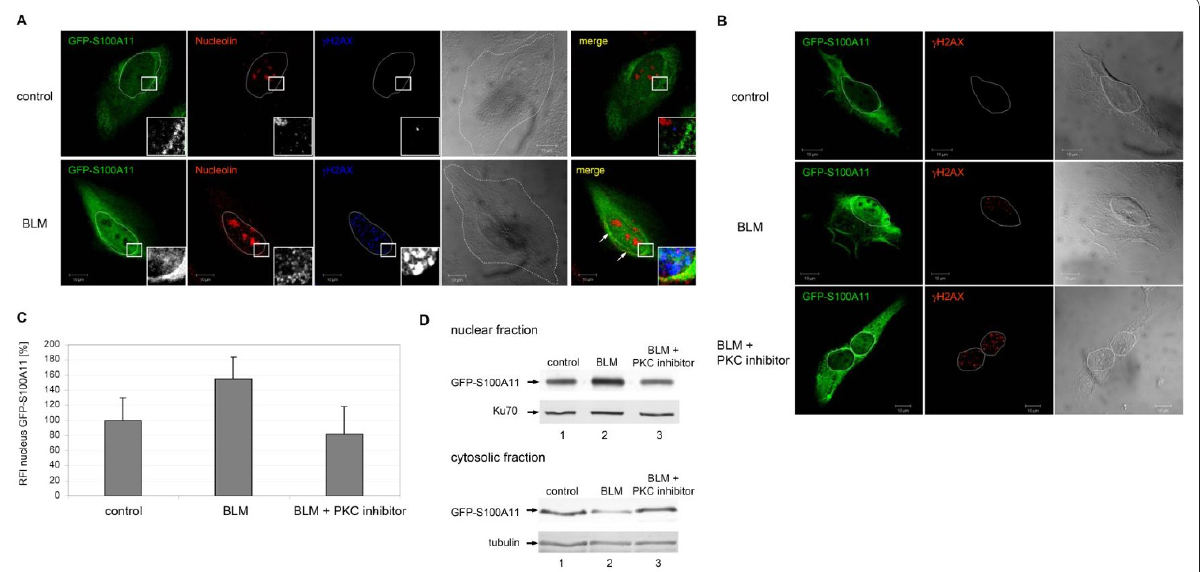
Figure 3 Nucleolin distribution during nuclear translocation of S100A11 in DNA damaged cells . (A) U-2 OS cells which expressed GFP- S100A11 were treated with BLM to induce DSB for 1 h followed by immuno-staining against GFP-S100A11 (green), nucleolin (red) and g H2AX (blue). The overlay image (merge) shows that GFP-S100A11 and nucleolin partially colocalize in the perinuclear region (labeled by arrows) in cells containing damaged DNA compared to control cells. Areas marked by a rectangle are shown enlarged in each image as insets. (B) Inhibition of phosphorylation of S100A11 by a myristolated PKC inhibitor interferes with S100A11 translocation. U-2 OS cells were transfected with a GFP- S100A11 construct and treated with BLM for 30 min or pre-treated with a PKC inhibitor for 17 hrs and subsequently with BLM. Cells were analyzed by two-color immunostaining followed by laser scanning microscopy for GFP-S100A11 (green) and g H2AX (red). (C) Quantification of the GFP-S100A11 relative fluorescence intensity (RFI) in nuclei of cells treated with BLM or BLM and a PKC inhibitor and in control cells by assessment of the GFP-S100A11 fluorescence intensity in several nuclear areas (2 μ m diameter) in percent. At least 14 cells for each condition were analyzed for quantification. Data are displayed as mean values (±SD). The average of the GFP-S100A11 fluorescence intensity measured in the control approach was set as 100%. (D) U-2 OS cells which expressed GFP-S100A11 were treated with BLM or with both BLM and the myristoylated PKC inhibitor. Afterwards, cytoplasmic as well as nuclear cell extract of treated cells and, as control, untreated cells were prepared and subjected to immunoblotting using a specific antibody against S100A11. As control for equal protein loading immunoblotting against nuclear protein Ku70 or cytosolic actin using specific antibodies were carried